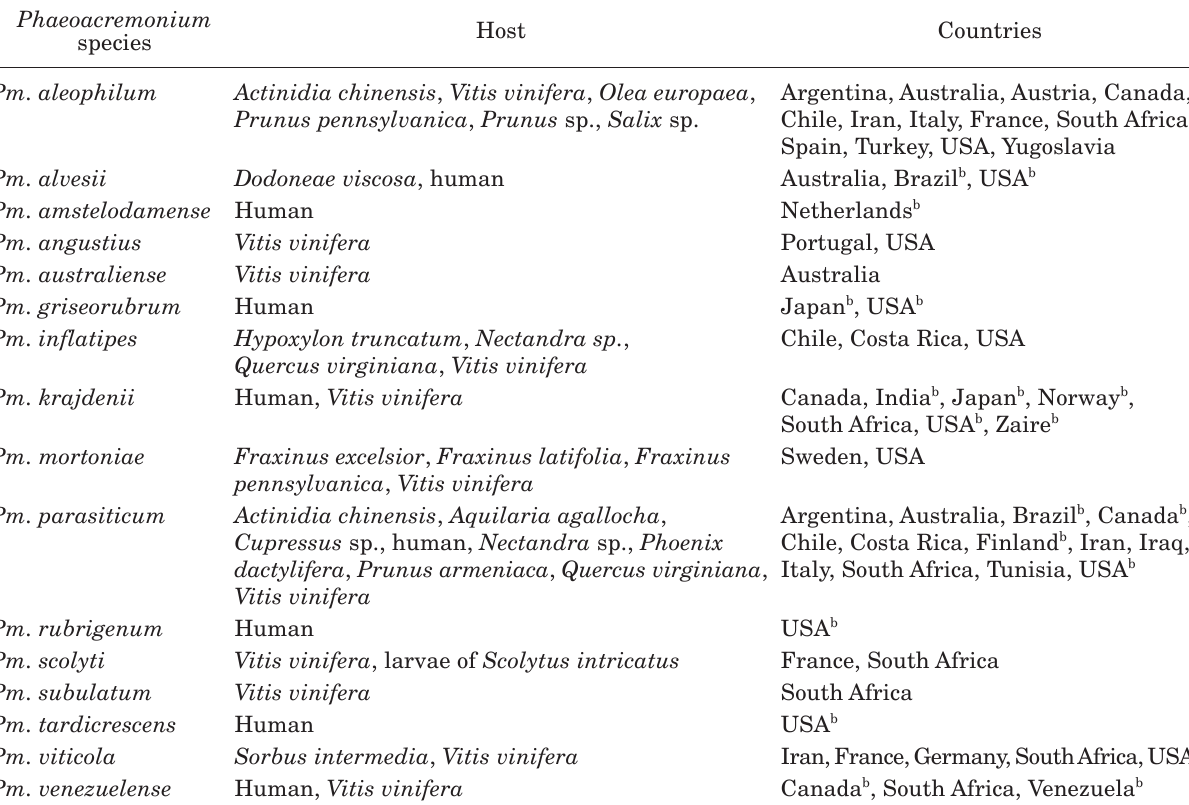
Table 1. List of Phaeoacremonium species, host range and world-wide distribution a . Phaeoacremonium